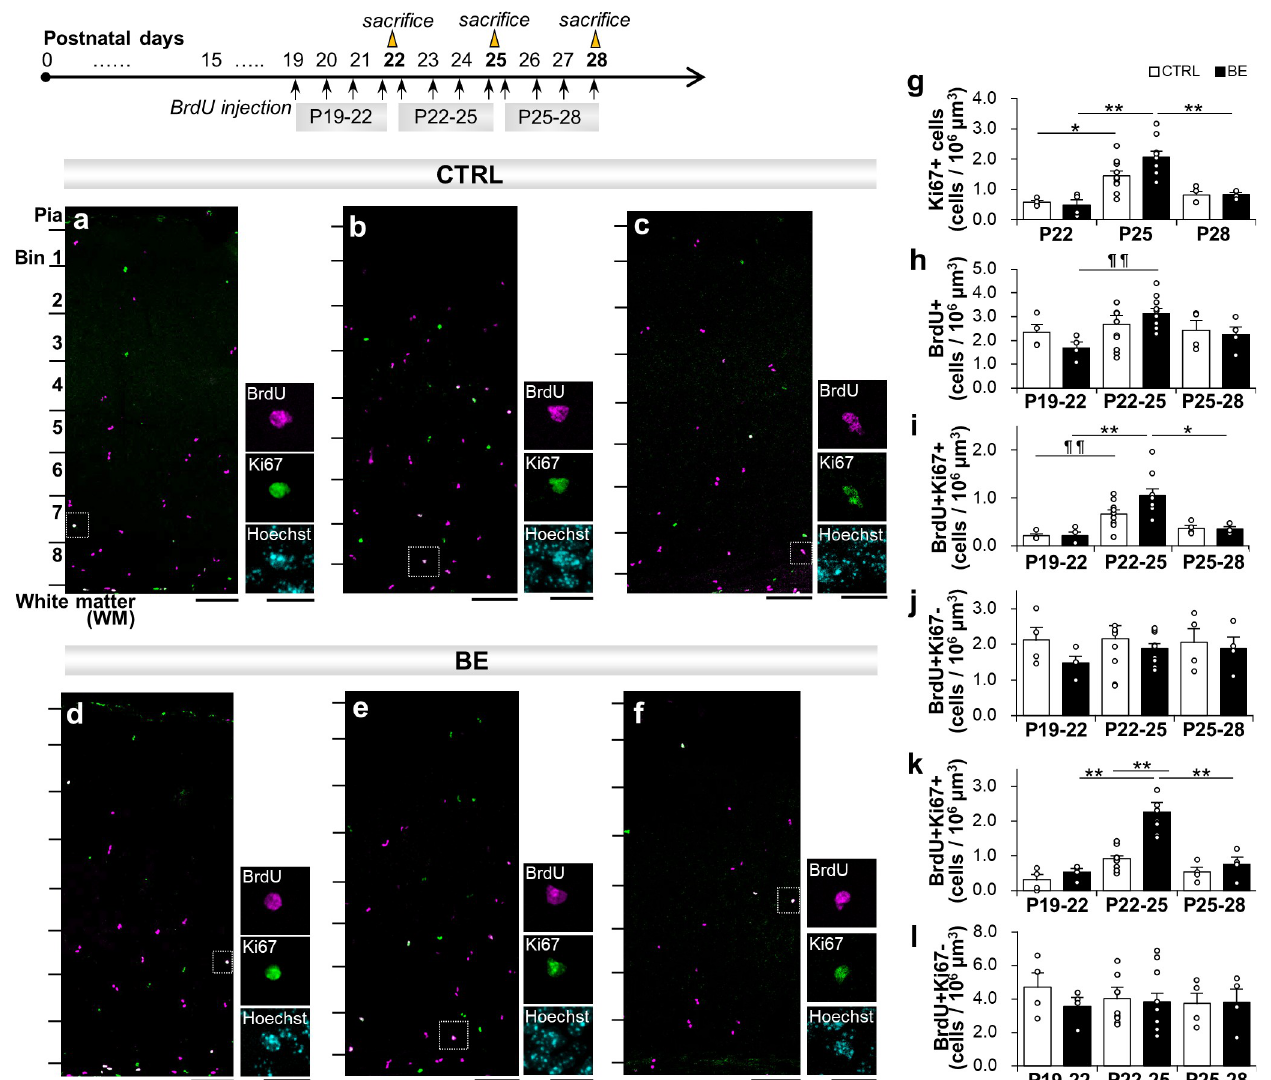
Fig 1. Cell proliferation analysis during postnatal development. Experimental scheme for labeling of proliferated cells. Mice were sacrificed at P22, P25, and P28 following daily injection of BrdU for 3 days (~72 hours). ( a-f ) Confocal immunofluorescence analysis with Ki67 (green) and BrdU (magenta) staining patterns in V1 in control ( a-c ) and BE mice ( d-f ) at P22 ( a , d ), P25 ( b , e ), and P28 ( c , f ). The magnified images of BrdU+Ki67+ cells are shown on the right side with Hoechst (cyan) staining for the nuclei. Scale bars, 50 μ m (left) and 20 μ m (right). ( g-j ) Cell densities of Ki67+ ( g ), BrdU+ ( h ), BrdU+Ki67+ ( i ), BrdU+Ki67- ( j ) cells in V1. N = 4 for P22; N = 10 for P25; N = 4 for P28 per group. ( k-l ) The cell density of BrdU+Ki67+ cells ( k ) and BrdU+Ki67- cells ( l ) in the bottom lamina (Bin 8). ¶¶p < 0.01 one-way ANOVA; � p < 0.05; �� p < 0.01, Tukey-Kramer post hoc tests after two-way ANOVA.